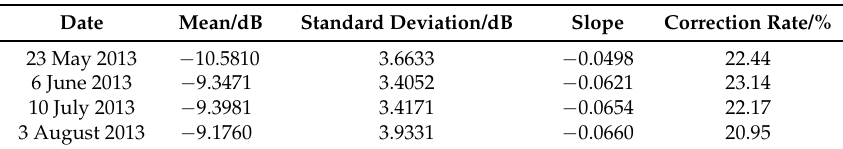
Table 5. Time series analysis of backscatter coefficient on RADARSAT-2 data sets for Yigen. Calculation time: 32 min.